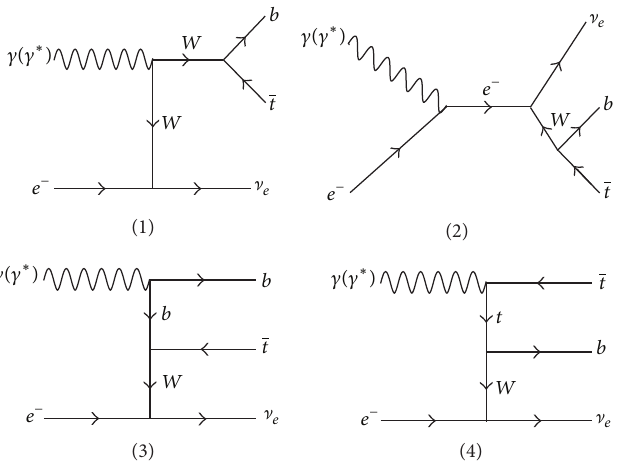
Figure 2: The Feynman diagrams contributing to the process 𝛾𝑒 − → 𝑡𝑏 ] 𝑒 and the subprocess 𝛾 ∗ 𝑒 − → 𝑡𝑏 ] 𝑒 .